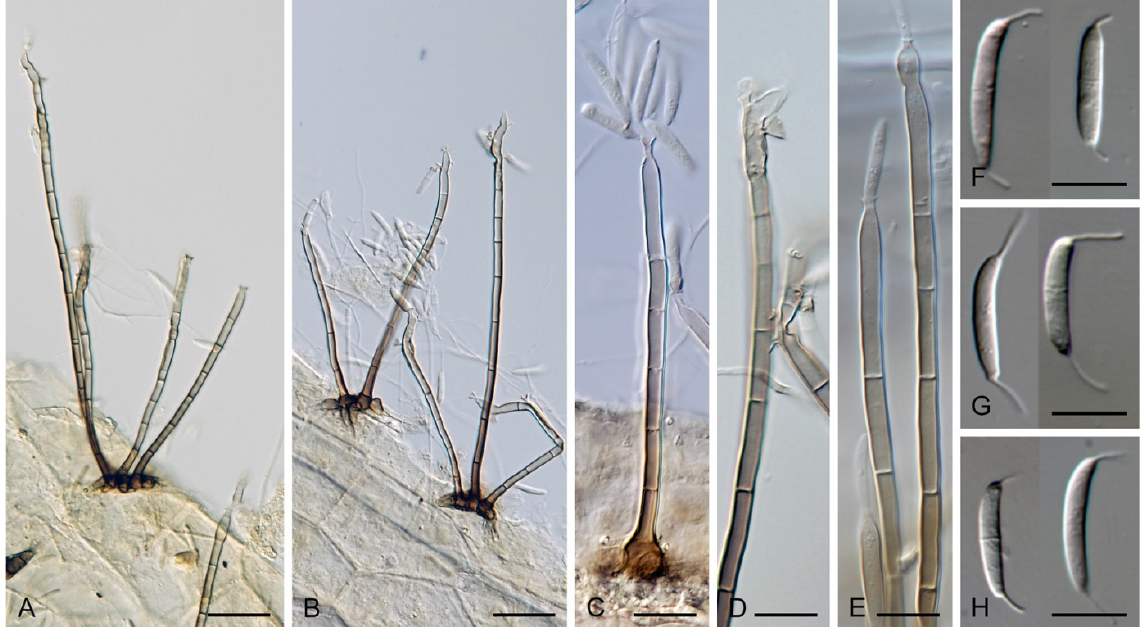
Figure 33. Stilbochaeta aquatica (CBS 114070, ex-type strain of Dictyochaeta curvispora ). ( A , B ) Setae with conidiophores ( C – E ) conidiophores ( F – H ) conidia. Images: ( A – H ) on a stem of U. dioica on CMA after 6–8 weeks. Scale bars: ( A , B ) 25 μ m ( C – H ) 10 μ m.